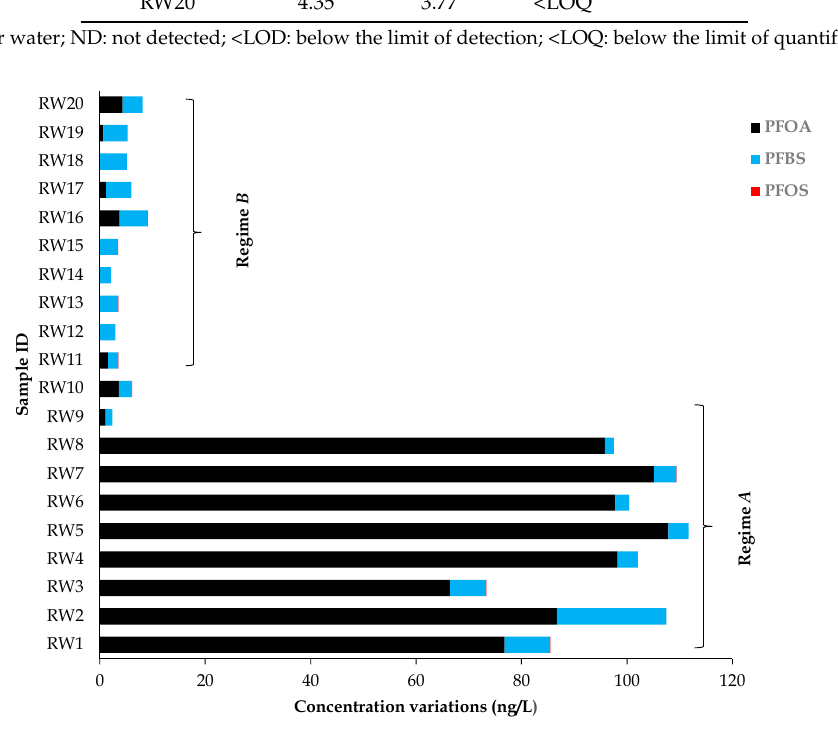
Figure 3. Individual PFAS concentration level variations for each sampling regime.